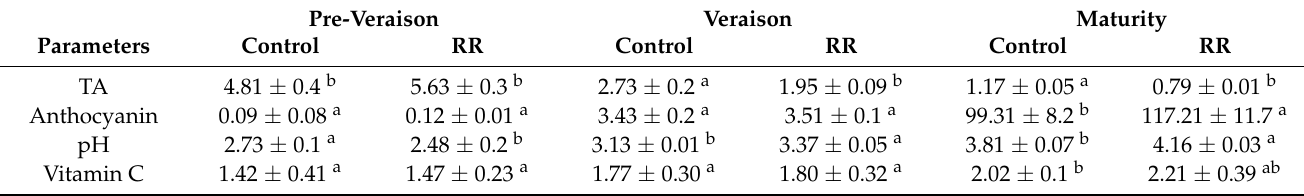
Table 1. Impact of treatment and control on fruit quality